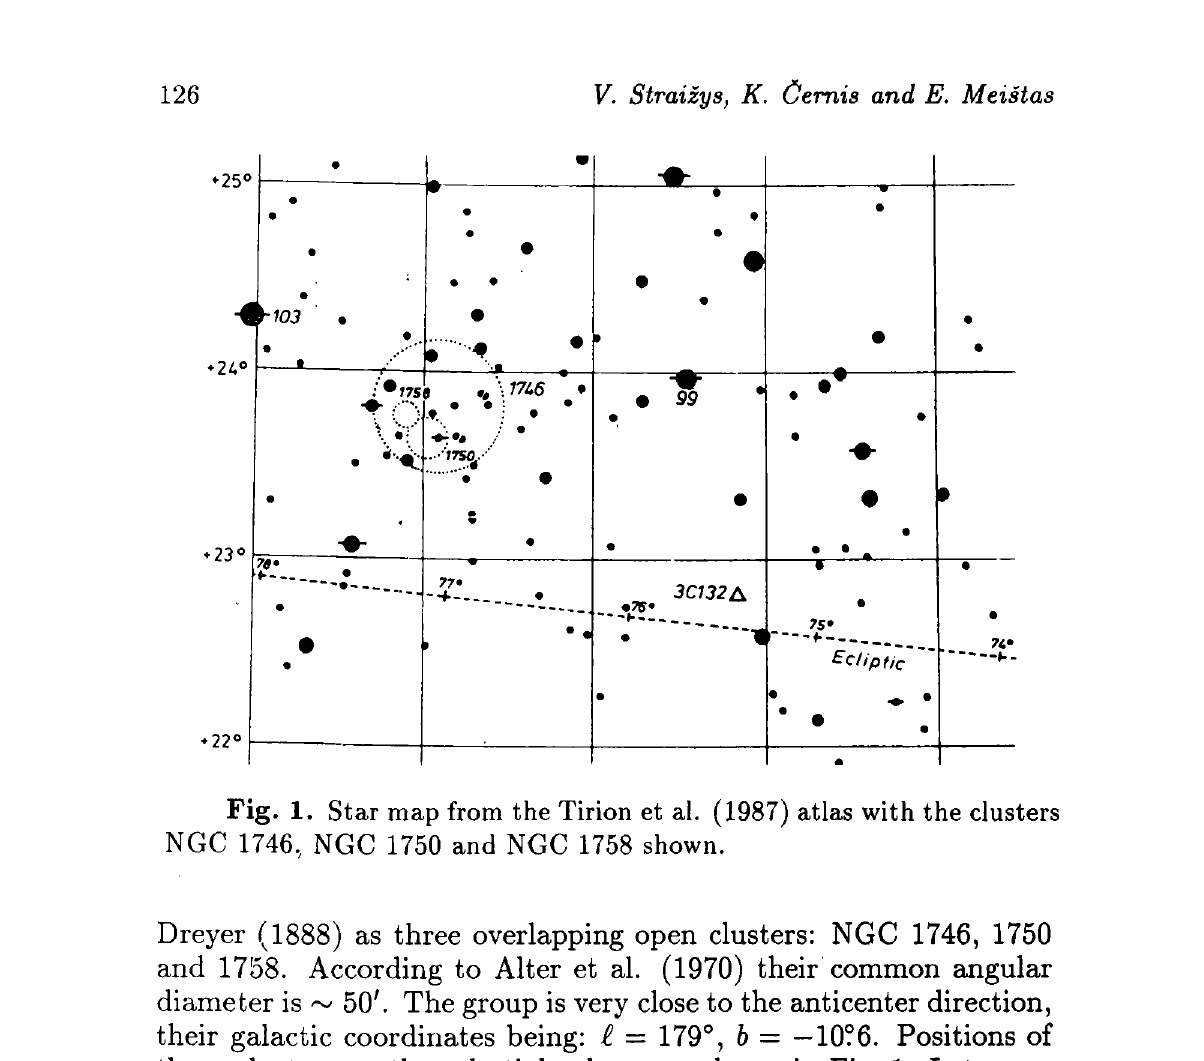
Fig. 1. Star map from the Tirion et al. (1987) atlas with the clusters NGC 1746, NGC 1750 and NGC 1758